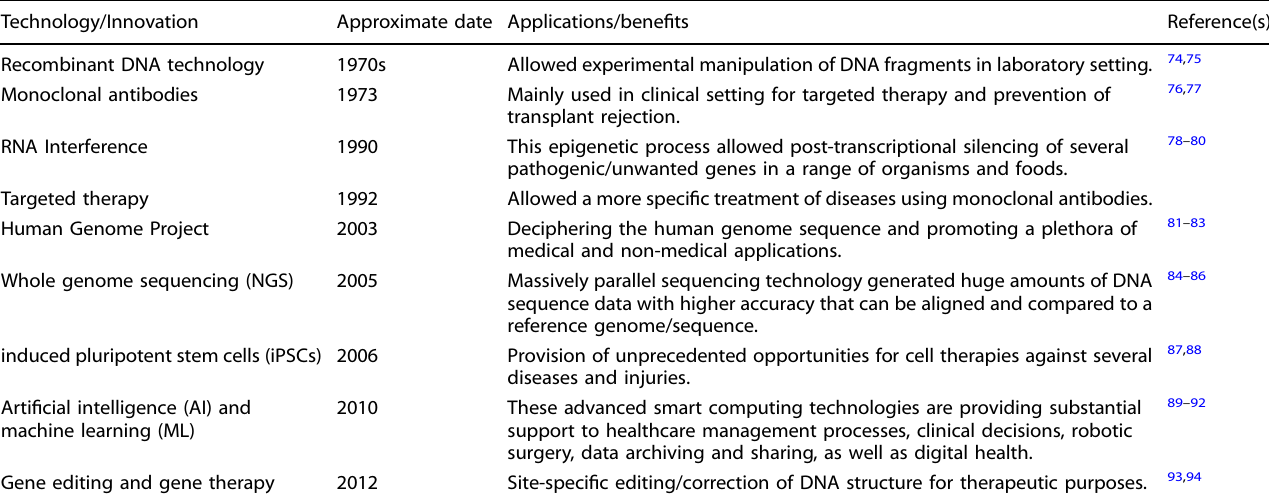
Table 1. An overview of the main recent innovations and advancements in biotechnologies and their potential applications to improve human